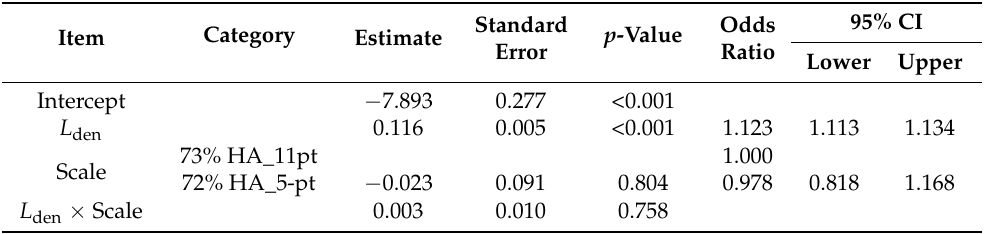
Table 5. Multiple logistic regression analysis of conventional railway noise surveys from 2001 to 2017 in Japan (AUC =